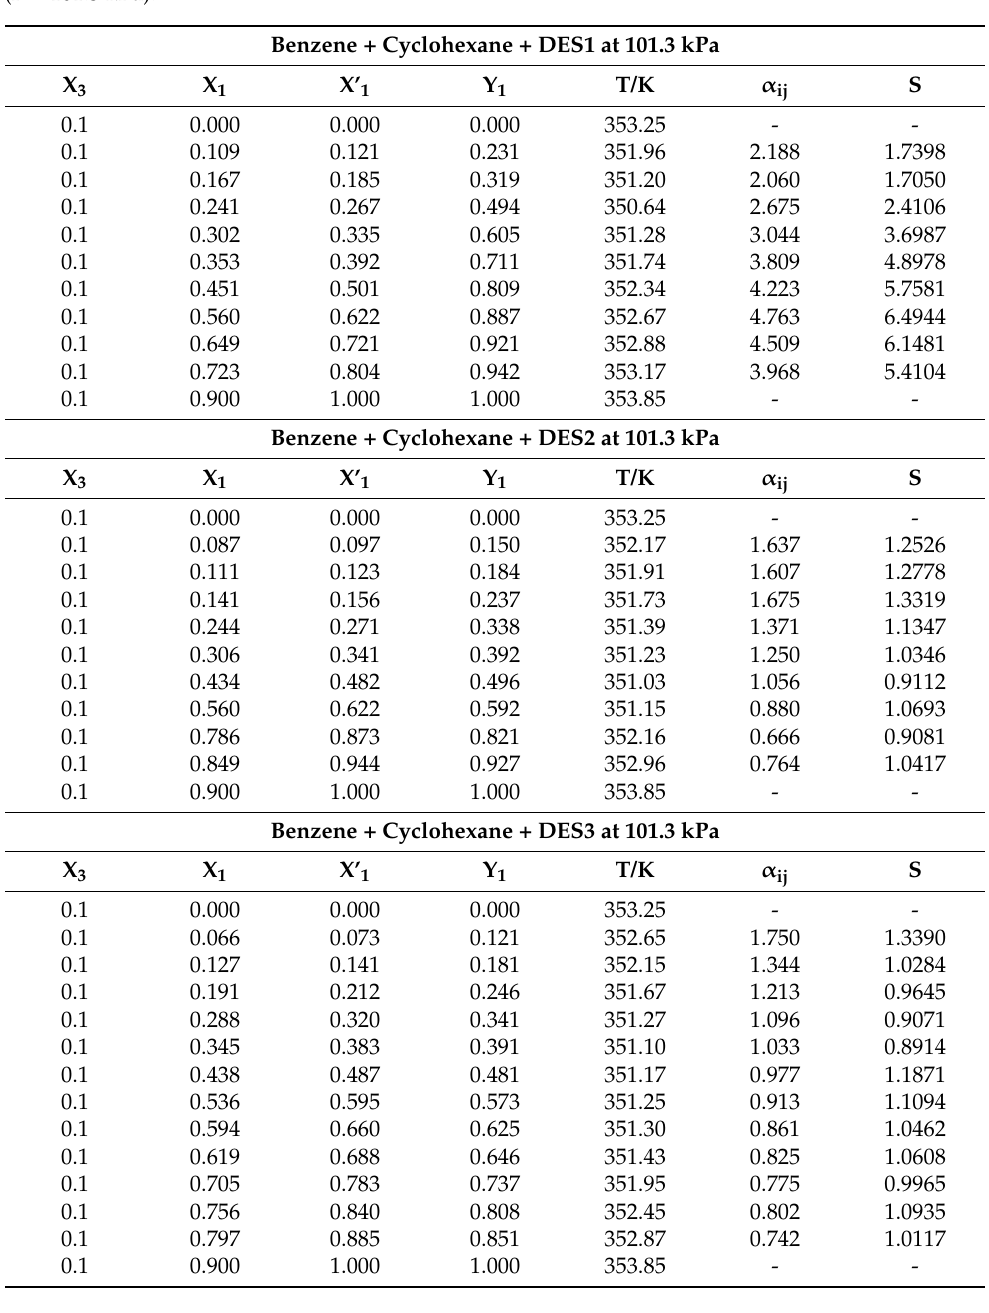
Table 2. The vapor-liquid equilibrium data of cyclohexane(1)-benzene(2)-DES(3) measured in Lab (P = 101.3